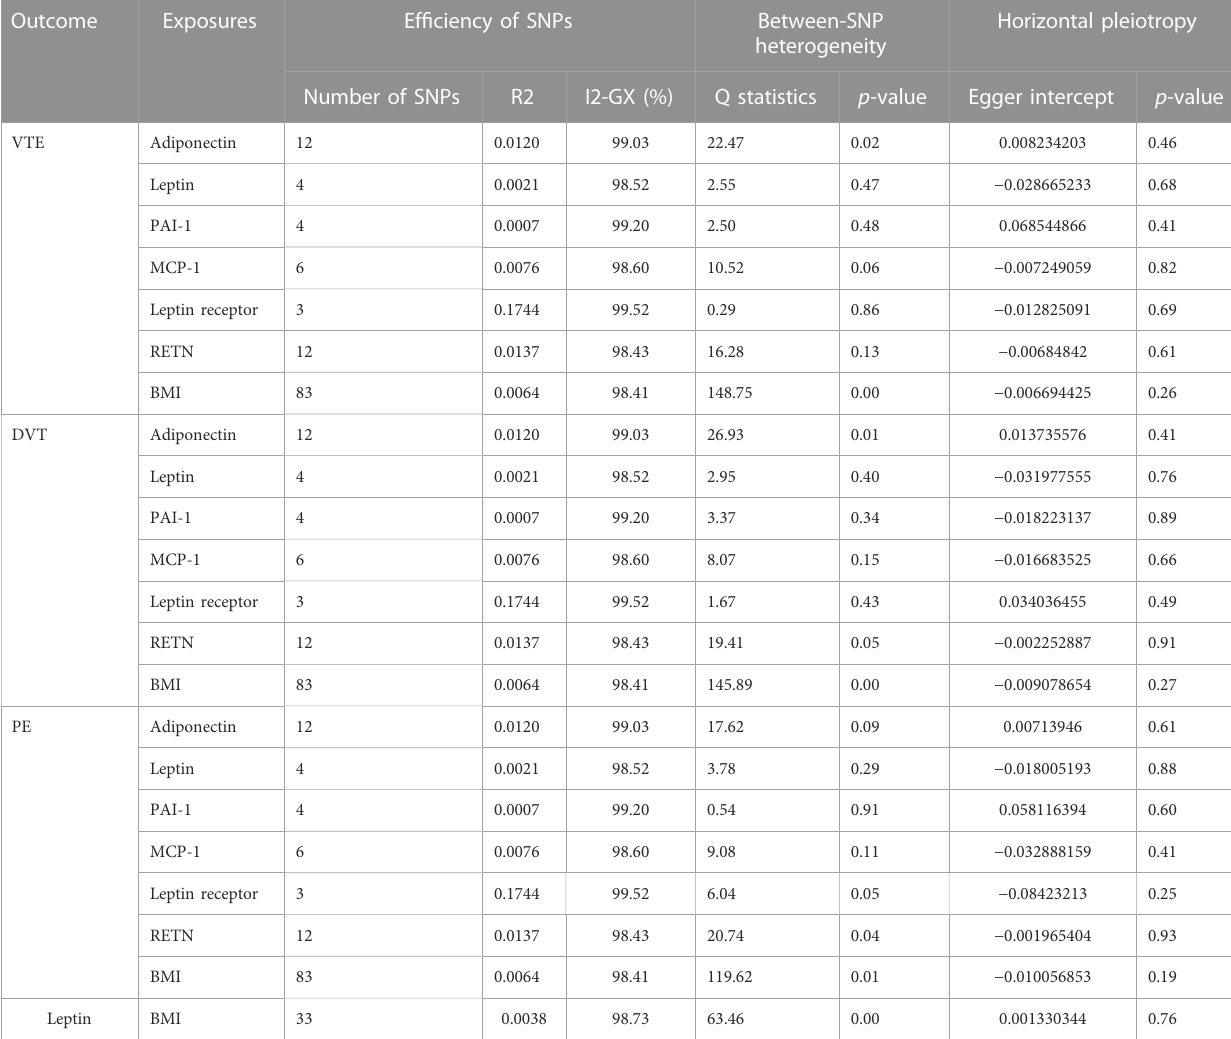
TABLE 2 Heterogeneity and pleiotropy analysis. Outcome